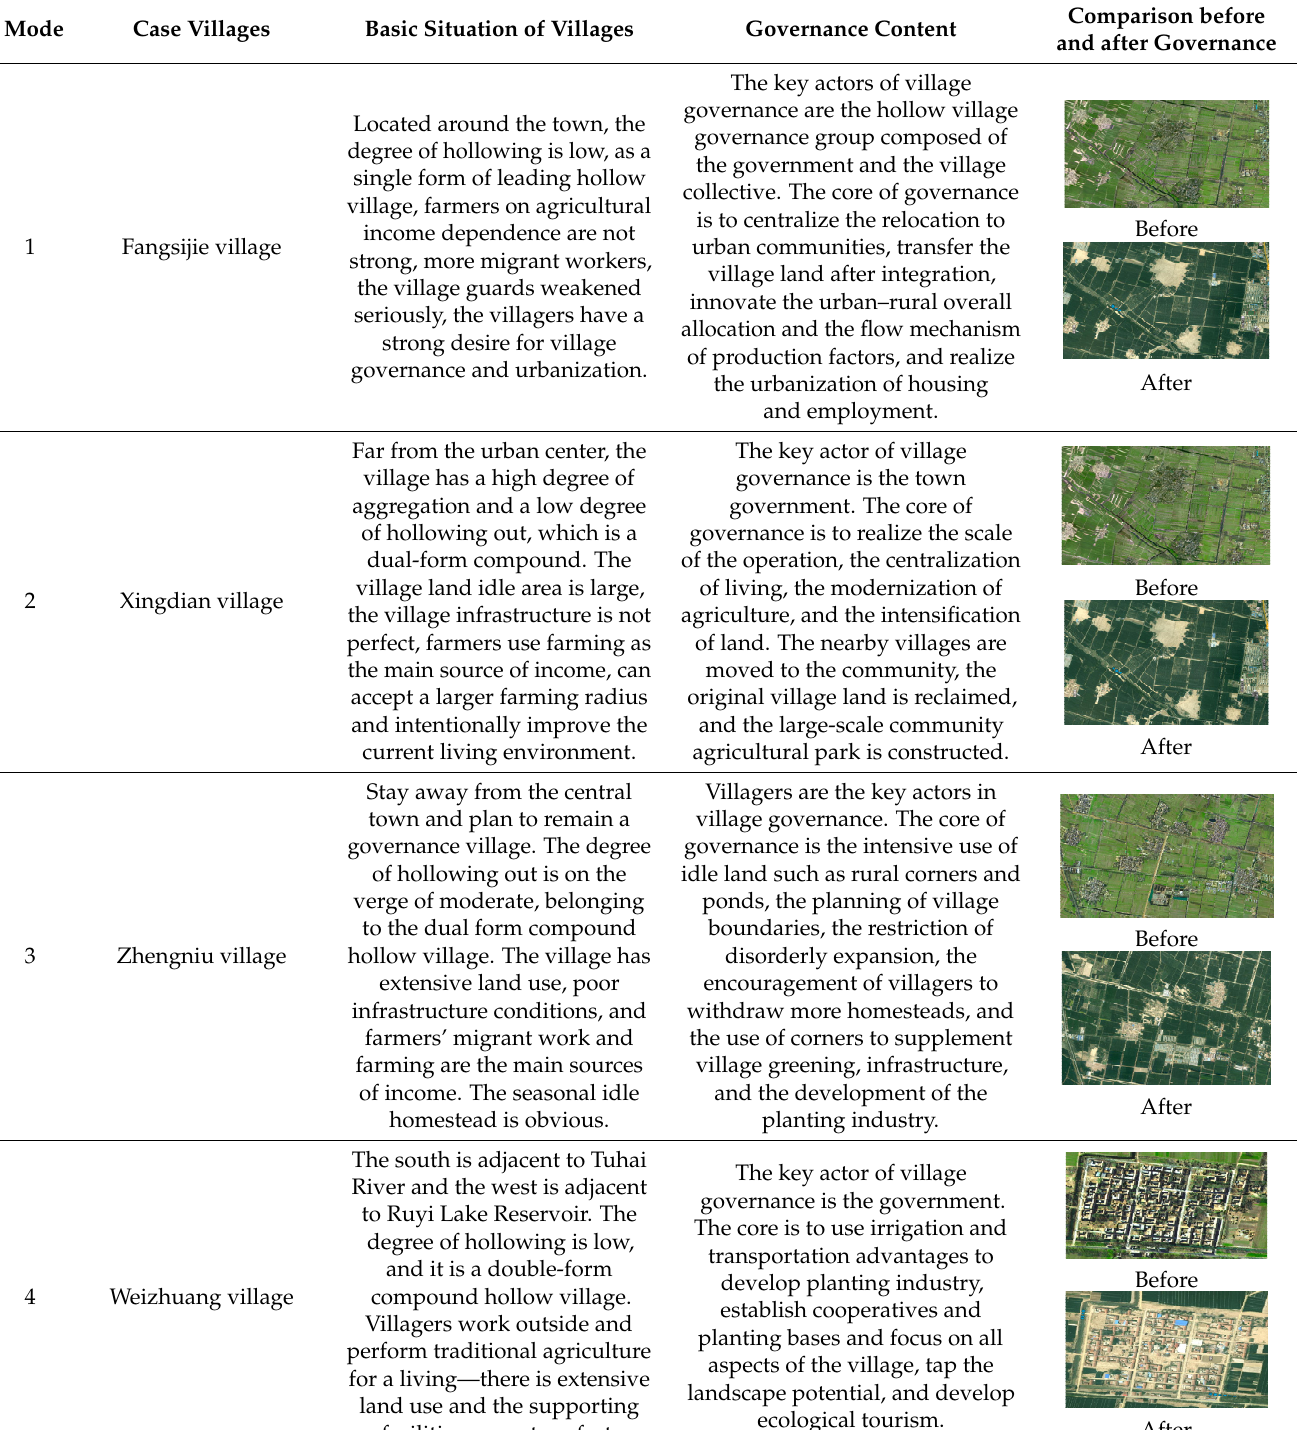
Table 2. Case village governance.